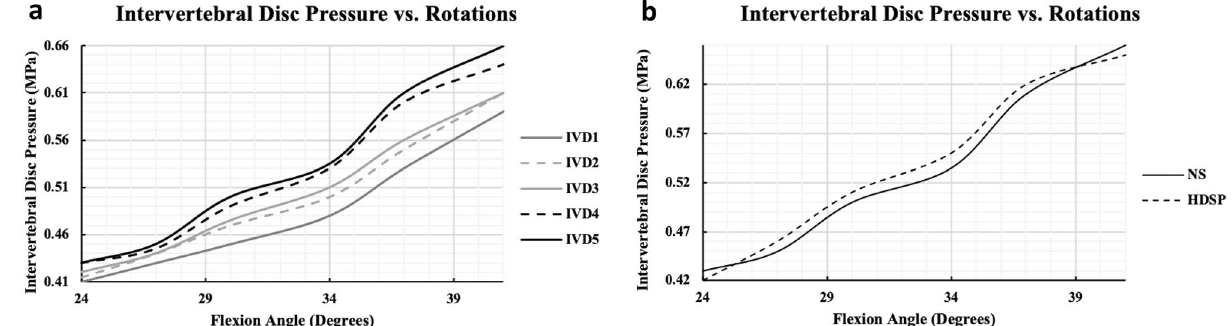
Figure 5. Intervertebral discs validation results. ( a ) Recorded lumbar intervertebral discs pressure as a result of spine flexion intensity, extracted via the average normal stress approach. ( b ) Verification of the normal stress approach via another two-state fluid–structure field using a hydrostatic pressure node.